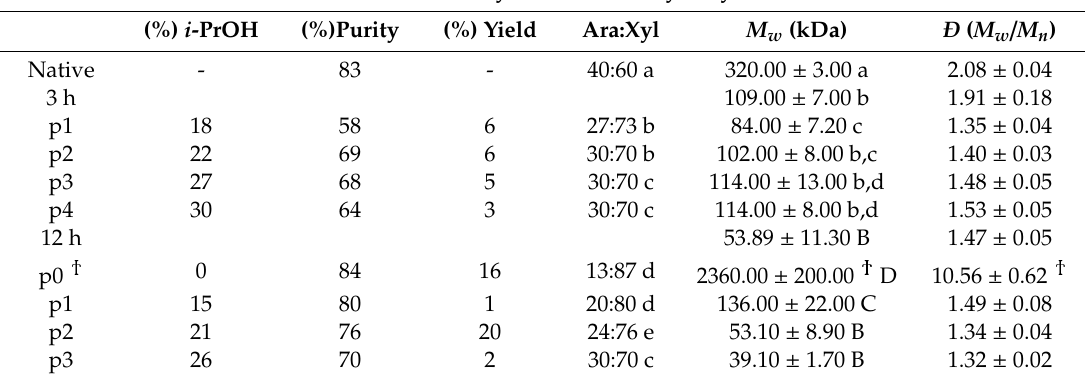
Table 5. M w and Ð variation of AX during 3 and 12 h acid hydrolysis before and after i -PrOH precipitation, with p1, p2, and p3 being the polysaccharide fractions collected during stepwise addition of i -PrOH. # Wheat Arabinoxylan [AX] HCl